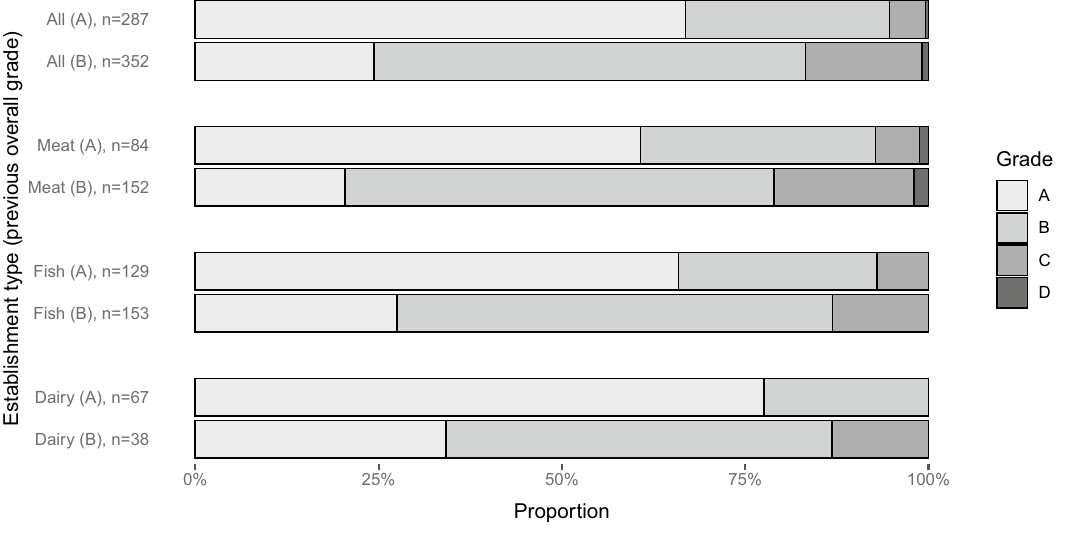
Figure 1. Grade distribution of the food production establishments’ first pre-planned inspection grouped by the grade of the previous inspection. Grade of the previous inspection denoted in parenthesis; A = Excellent, B =